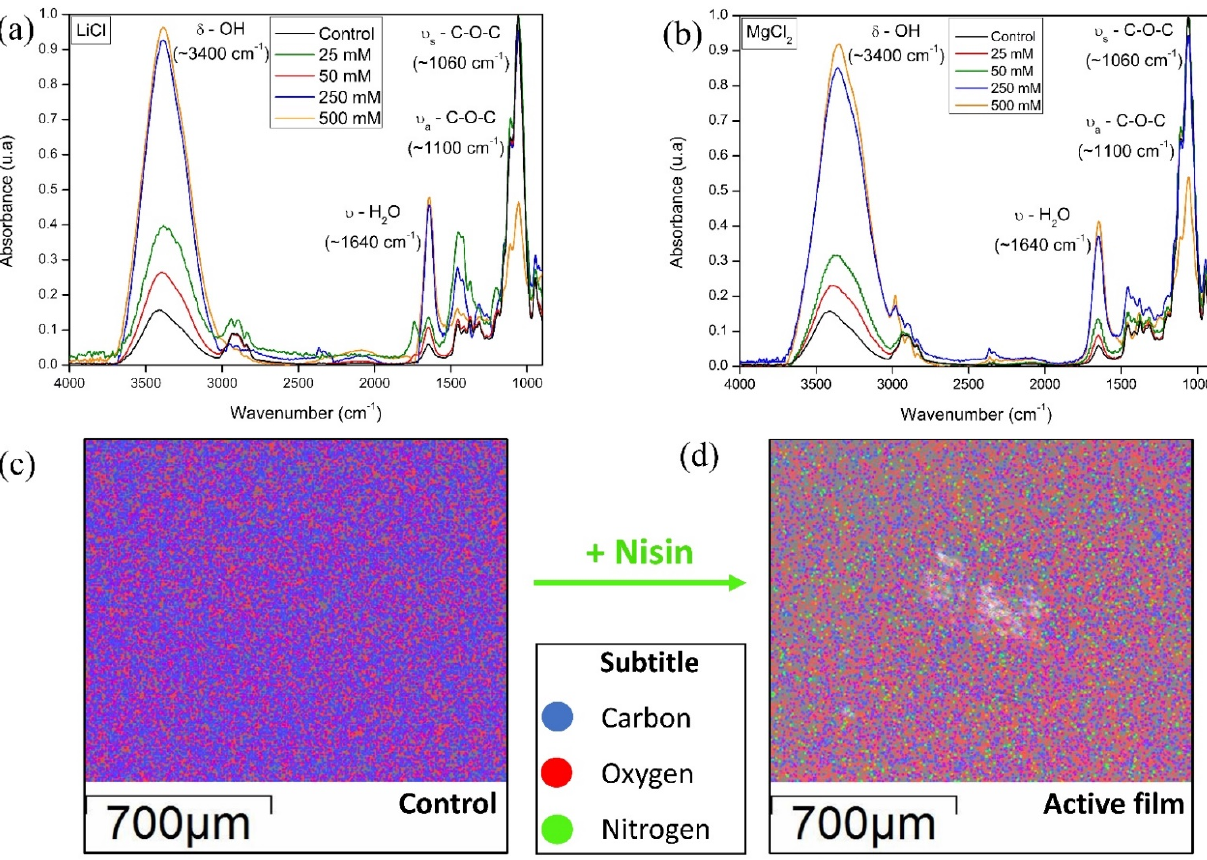
Figure 1. FTIR spectra of MC-based films with 0, 25, 50, 250, and 500 mM due to LiCl ( a ) or MgCl 2 addition ( b ), and the EDS full elemental maps of ( c ) control film (0 mM of IS) and ( d ) active film (0 mM of IS) incorporated with Nisin-Z.